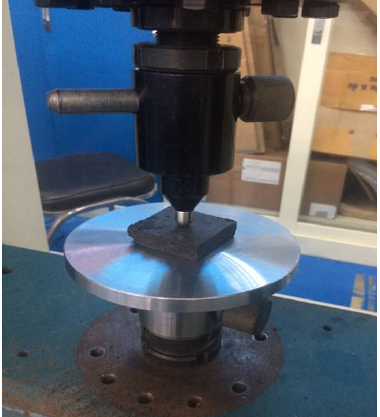
Figure 1. Hardness test of the samples.